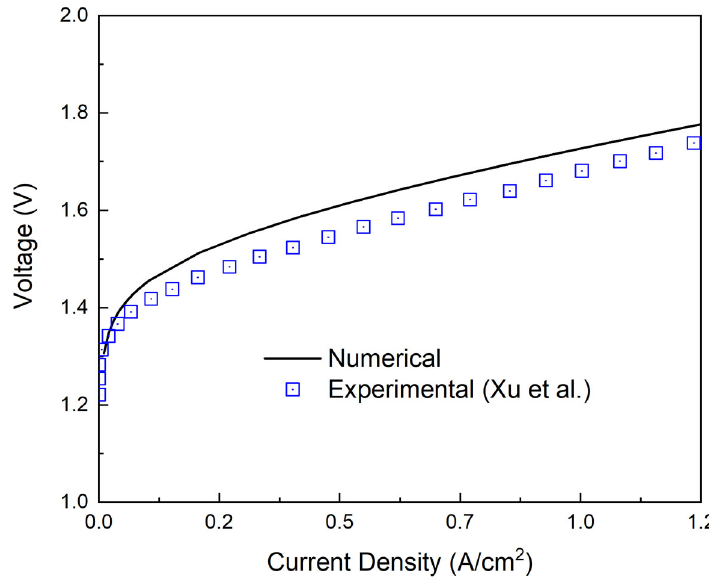
Figure 4. Comparison and validation of the present model with experimental